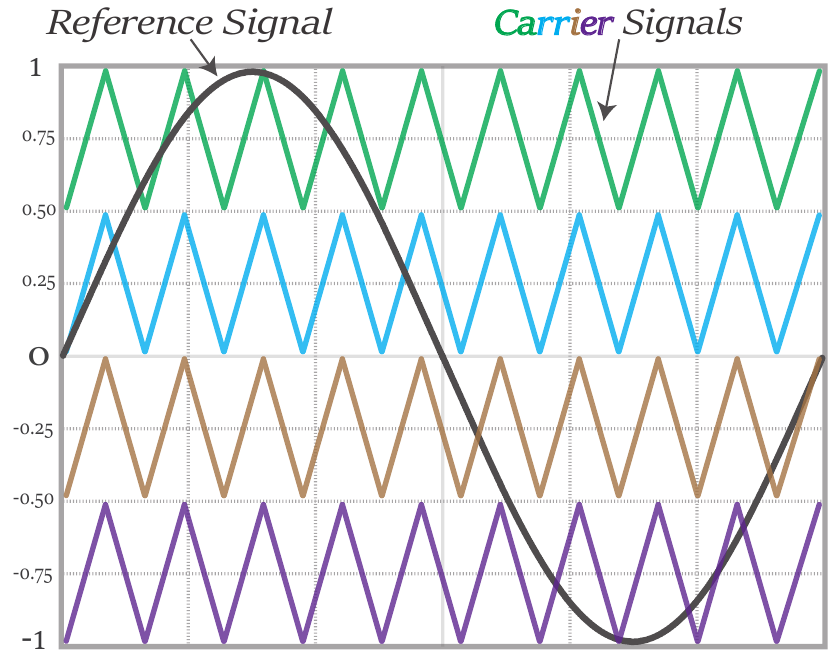
Figure 3. LS-PWM technique for five-level CHB